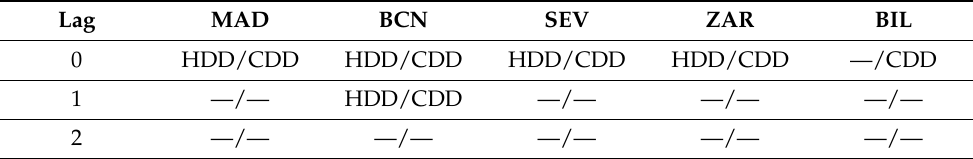
Table 2. Temperature variables significant at a 0.05